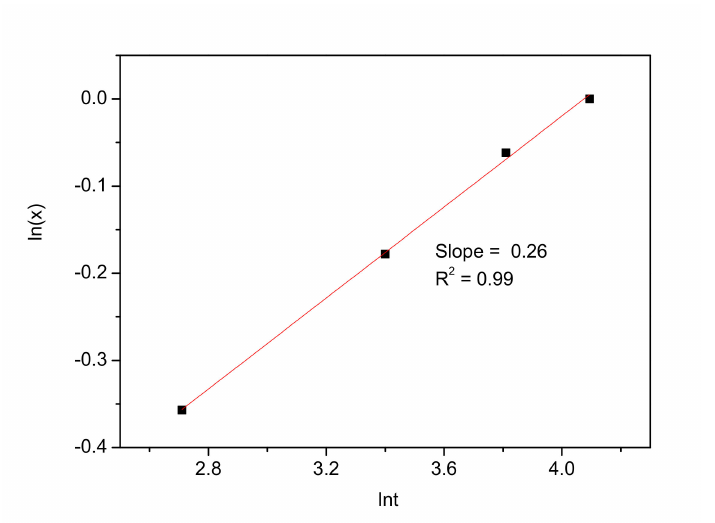
Figure 8. Application of the rate equation for mass transfer control to the data obtained at 60 ◦